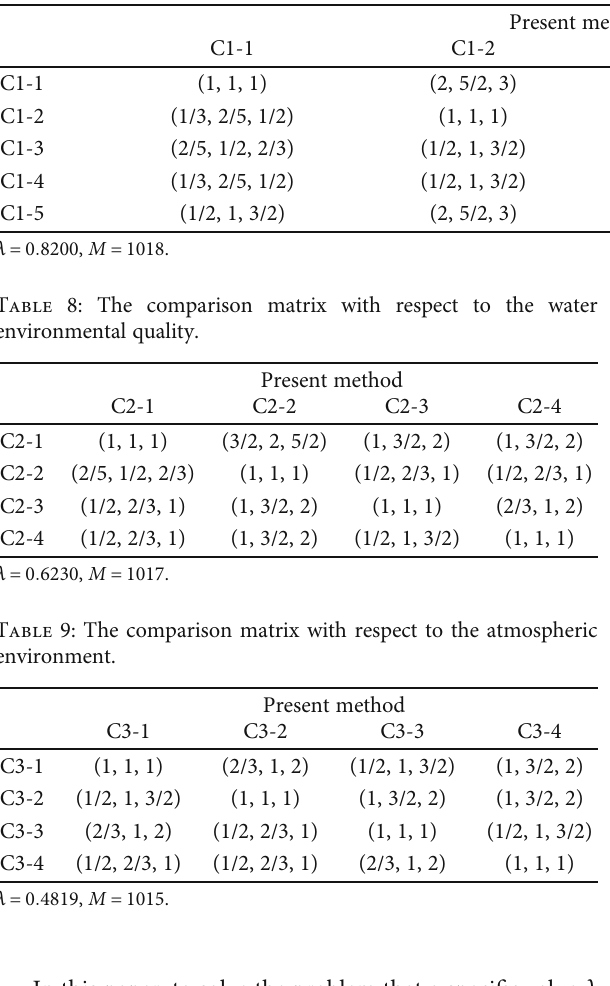
Table 7: The comparison matrix with respect to the soil quality.